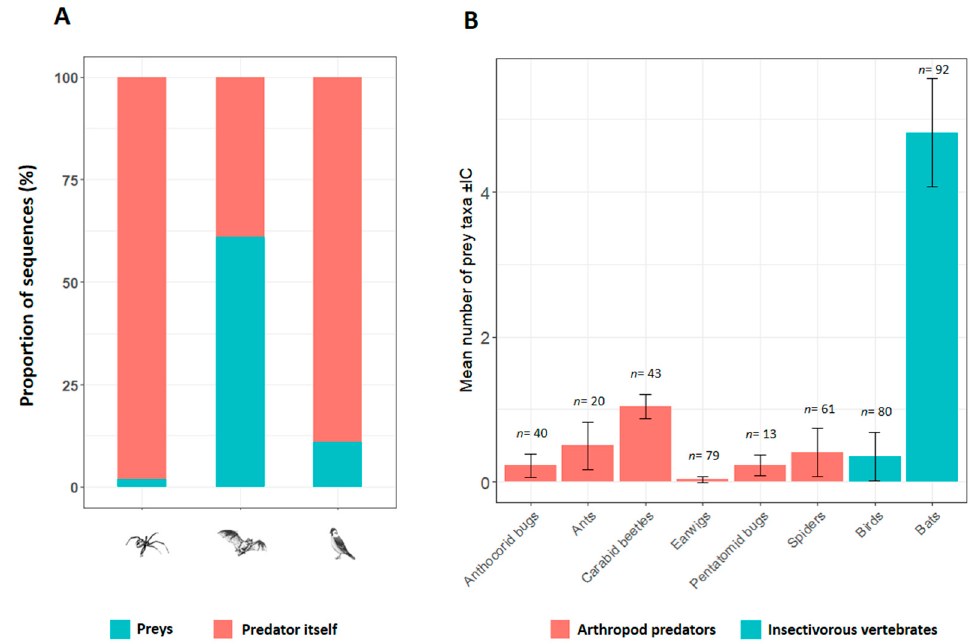
Figure 1. ( A ) Proportion of sequences attributed to predators themselves (arthropods, bats and birds) or its preys. ( B ) Mean number of prey taxa detected in arthropod guts or fecal samples of insectivorous vertebrates. IC: 95% confidence interval. n : number of samples.